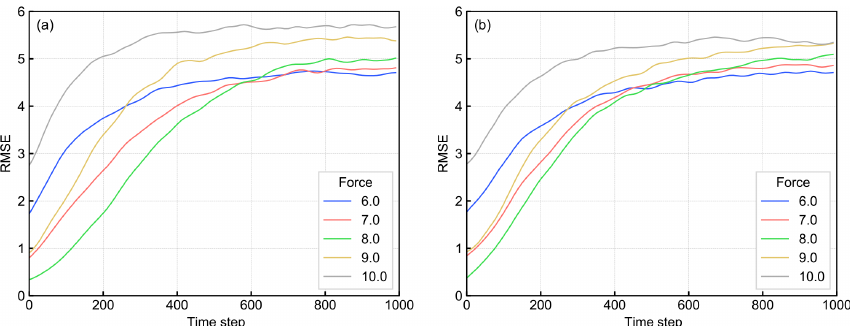
Figure 9. The mRMSE time series of the predictions of (a) LETKF-Ext and (b) RC-Anl with a biased model. Each color corresponds to each value of the F term.